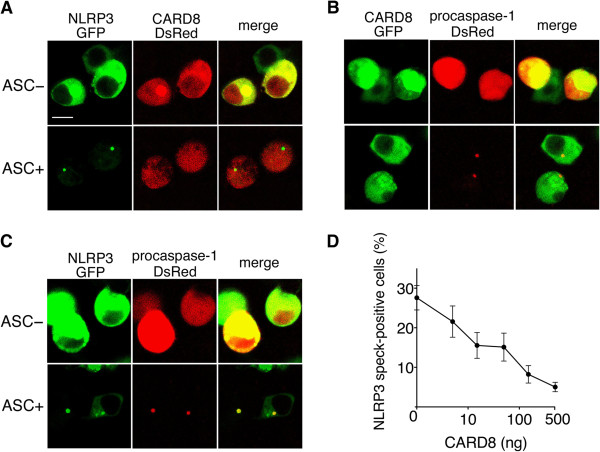
Suppression of NLRP3-speck formation by CARD8. (A) Human Embryonic Kidney (HEK)293 cells were cotransfected with expression plasmid constructs of NLRP3-GFP, caspase recruitment domain-containing protein 8 (CARD8)-DsRed, procaspase-1, and either apoptosis-associated speck-like protein containing a CARD (ASC) or an empty vector. After 24 hours, green and red fluorescent signals were detected by a confocal laser scanning microscope. The scale bar represents 10 μm. (B) The same as A except for using NLRP3, CARD8-GFP and procaspase-1-DsRed. (C) The same as A, except for using NLRP3-GFP, CARD8 and procaspase-1-DsRed. (D) HEK293 cells were cotransfected with expression plasmids for NLRP3-GFP (30 ng), ASC (5 ng), procaspase-1 (2.5 ng), proIL-1β (30 ng) and CARD8 (5, 15, 50, 150 or 500 ng) or an empty vector. At 24 hours after transfection, the percentage of NLRP3-GFP-speck positive cells in the transfected cells was determined. Data represent the mean ± SD (n = 9).